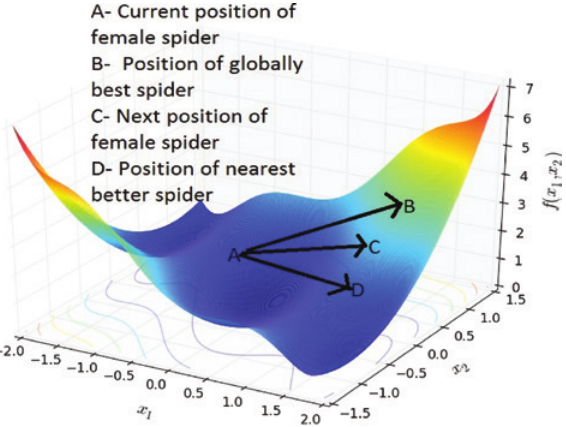
Figure 2: Generation of the Next Position of Female Spider (Reprinted from [33]).